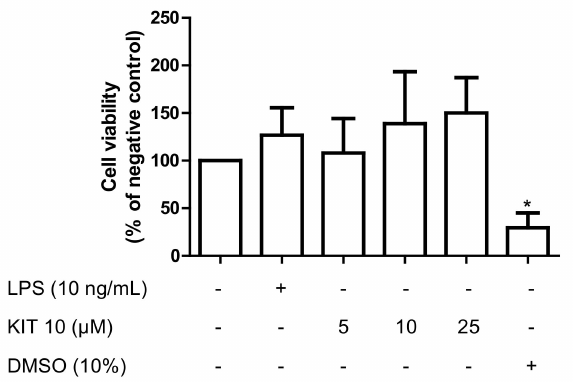
Figure 1. Effects of KIT 10 on cell viability in primary rat microglial cells. KIT 10 was added 30 min before stimulating the cells with LPS for 24 h. Levels of ATP were measured by the CellTiter-Glo ® luminescent cell viability assay. * p < 0.05 with respect to vehicle-treated microglial cells (One-way ANOVA followed by the Newman-Keuls